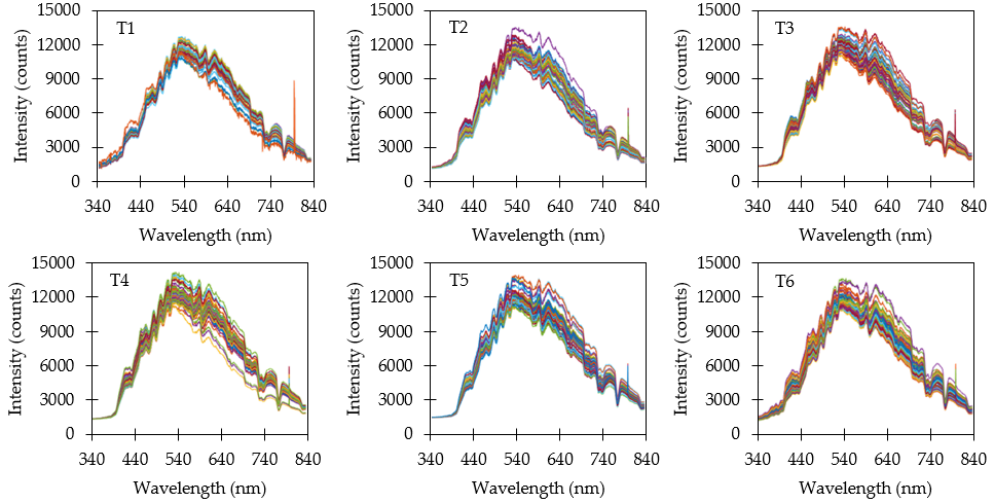
Figure 5. Reflectance measurements using a variable integration time (M1). Saturated and low − intensity measurements due to changing targets were removed from the dataset. Variable integration time caused the reflectance spectra to be tightly grouped near the targeted maximum